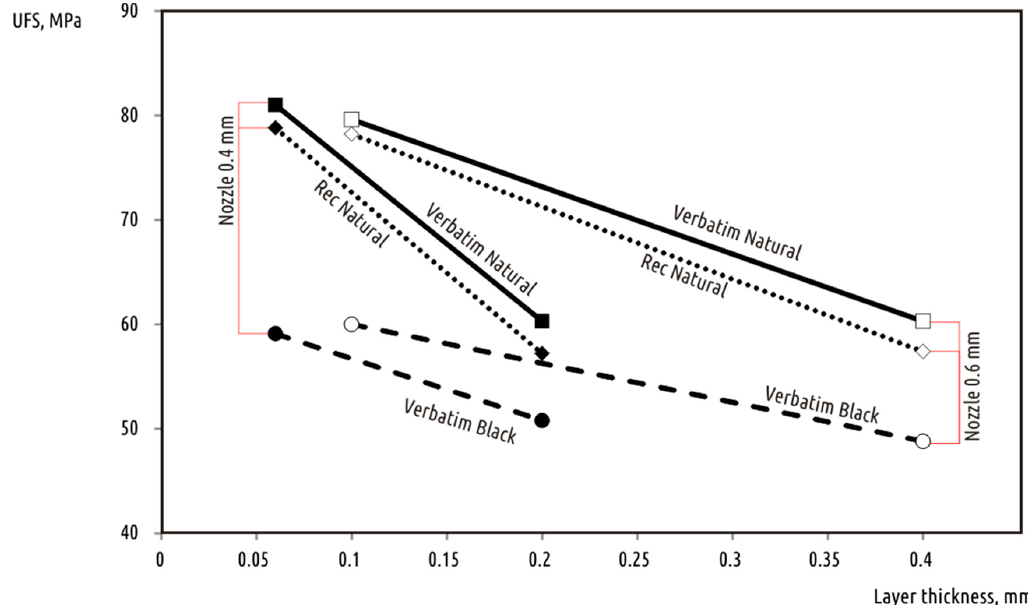
Figure 6. Ultimate flexural strength versus deposited layer height for additional materials tested.